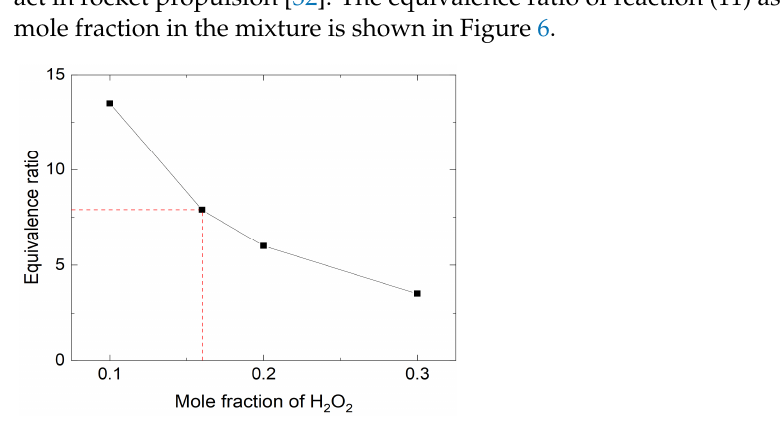
Figure 6. Equivalence ratio of reaction (11) as a function of mole fraction of H 2 O 2 in the mixture. The red dashed line indicates the location of the rich flammability limit of (11) as suggested by our find- ings.